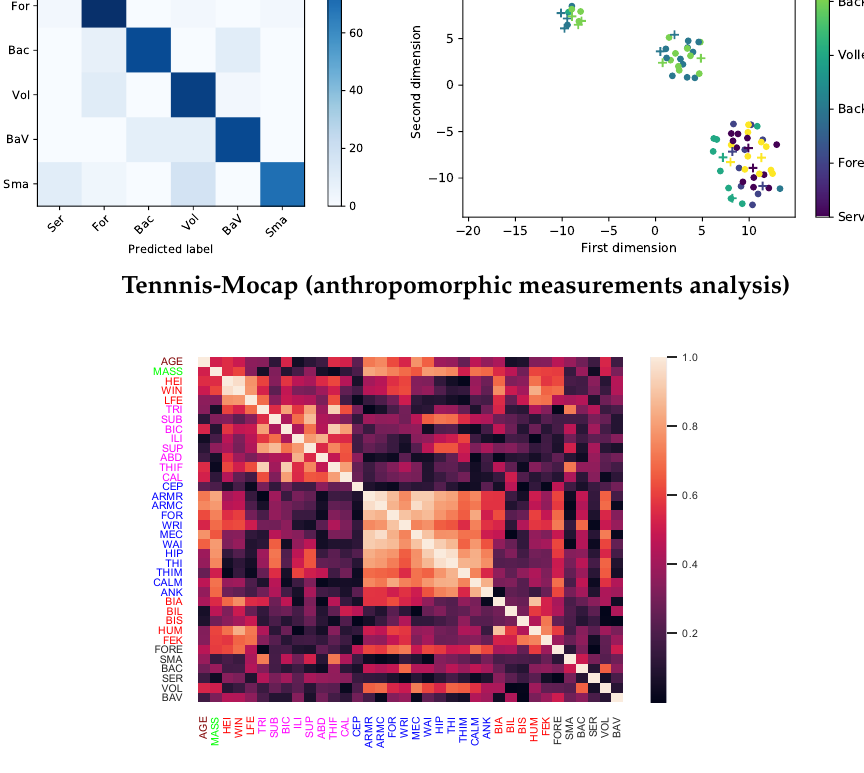
Figure 6. EHECCO-based classification and anthropomorphic measurement results for Tennis-Mocap database. Top left : confusion matrix (action recognition). Top right : t-SNE-based 2D projection from EHECCO distance. Bottom left : Absolute value of the Pearson’s correlation coefficient between the EHECCO first t-SNE-based mean projection of each player’s videos and his/her anthropomorphic measurements. The most relevant correlations are